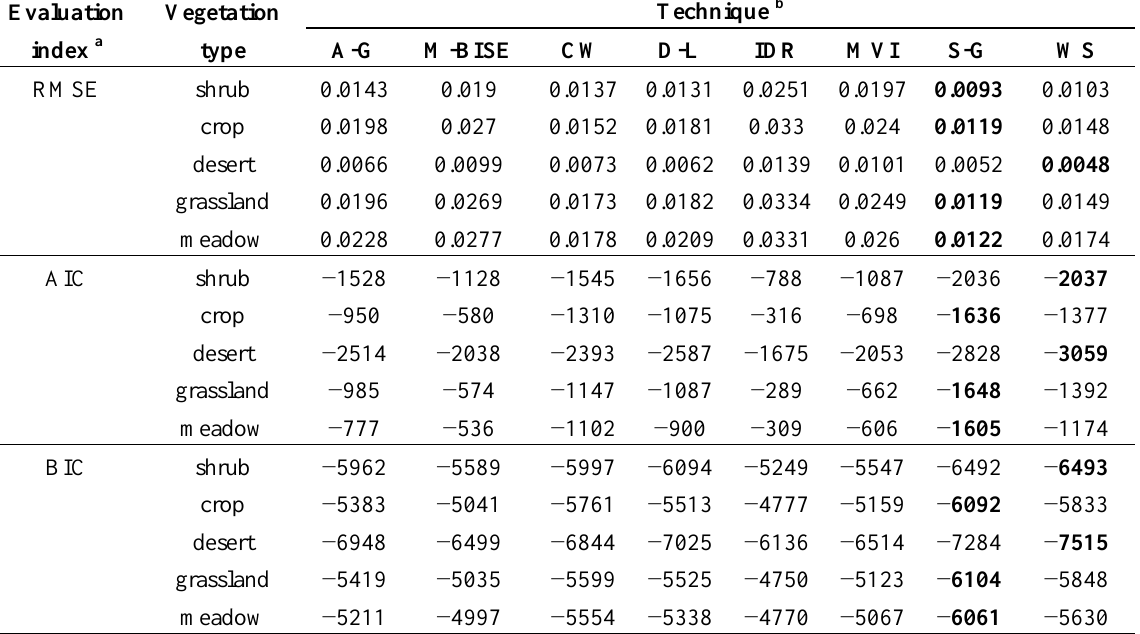
Table 4. RMSE, AIC, and BIC values for the eight techniques for the Pathfinder AVHRR Land (PAL) NDVI time-series data from July 1981 to December 2000 (except August 1994–December 1994) (best-fitting technique shown in